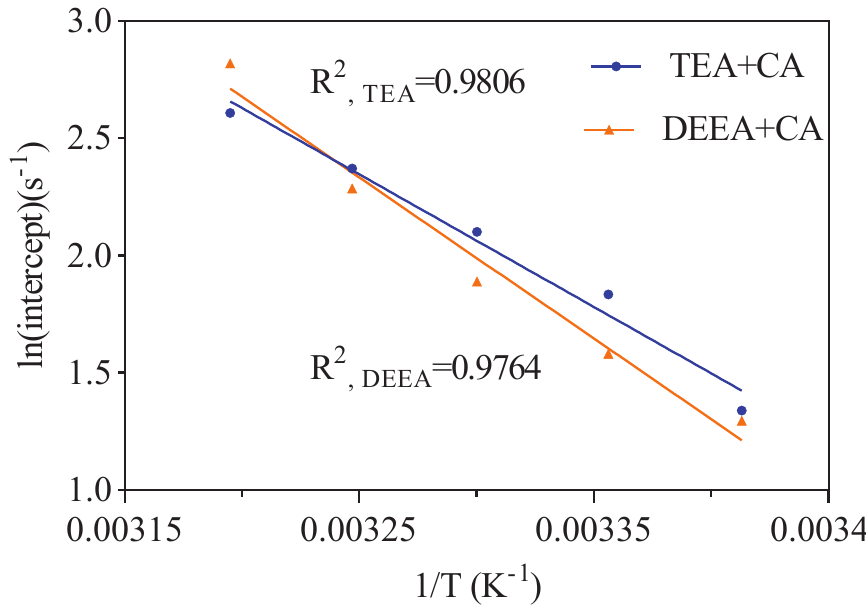
Figure 8. Plot of the values of intercept with 3 g/m 3 CA in CO system at temperatures of 293–313 K in Figure 7.